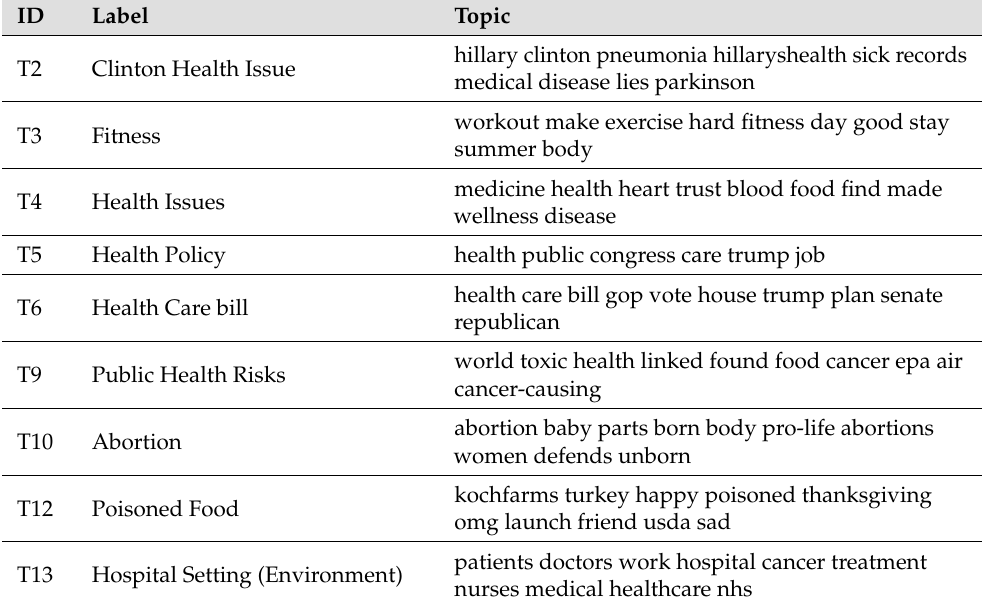
Table 1. Topics of tweets posted by Russian